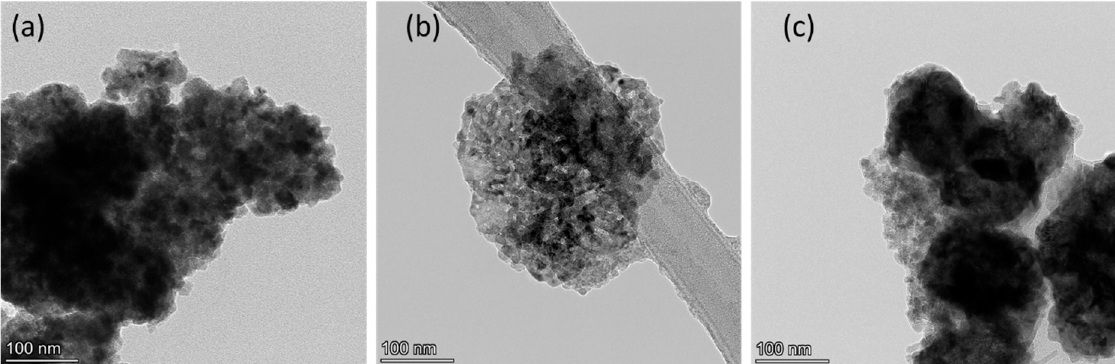
Figure 3. TEM micrographs of Co oxide/Co/Co Oxide nanoparticles oxidized for ( a ) 0, ( b ) 5, and ( c ) 40 min.